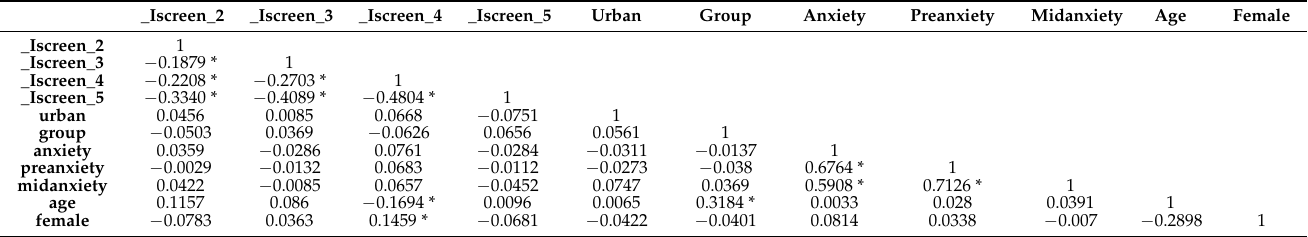
Table A2. Spearman correlation matrix (recreation screen time as dummy